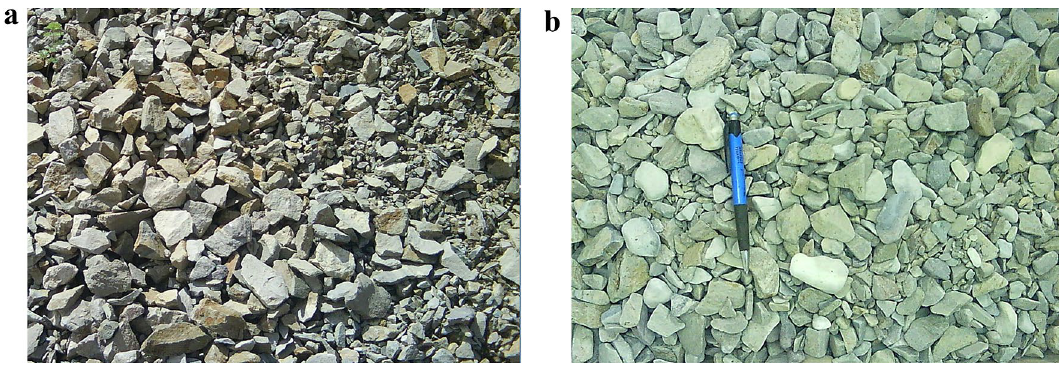
Figure 1. Soil particles. ( a ) Angular particle shapes. ( b ) Sub-angular particle